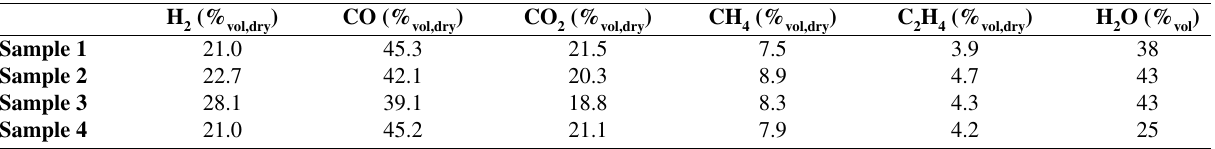
Table 3. Composition of product gas in the semi-industrial 750 kW plant. Samples refer to the same experiment. H (% ) 2 vol,dry